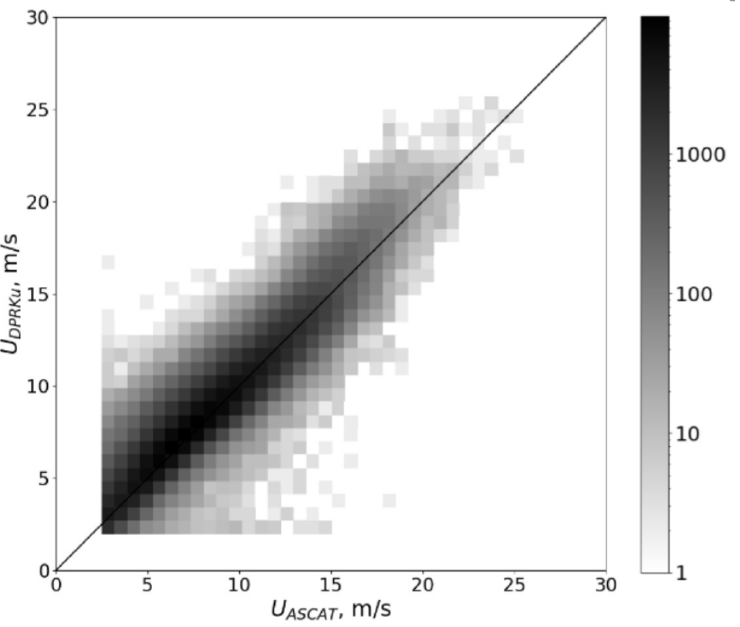
Figure 6. Comparison between wind speed from the Dual Frequency Precipitation Radar (DPR) and ASCAT